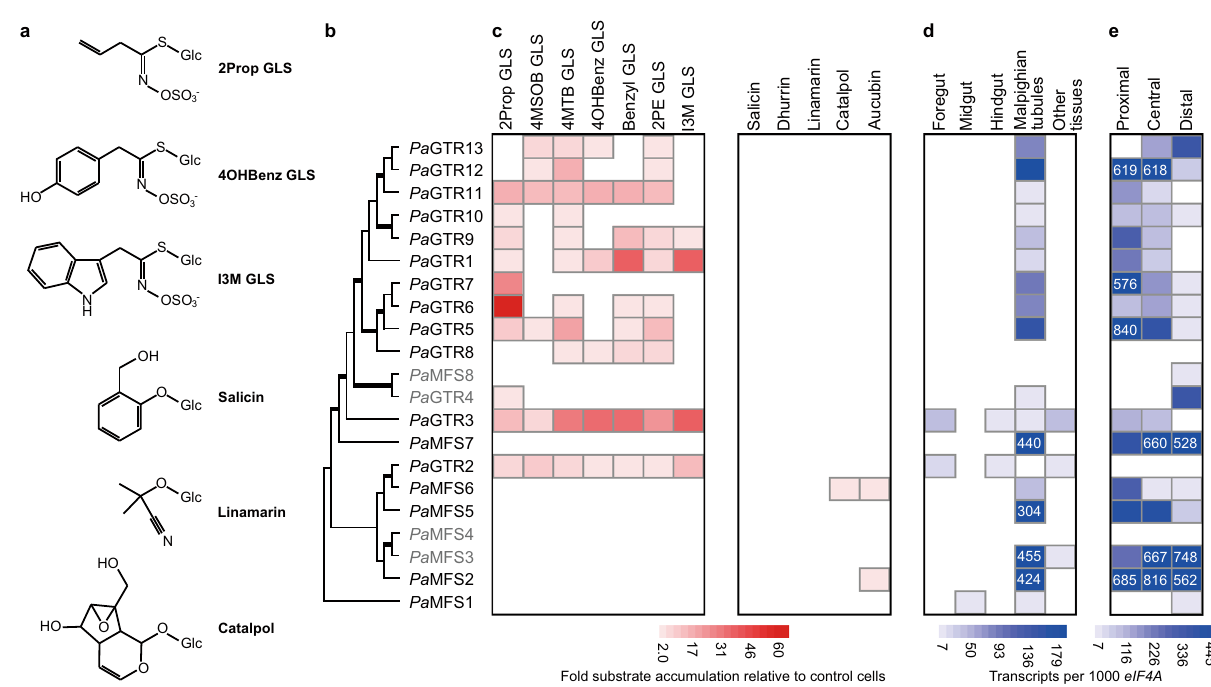
Fig. 1 Import activity and expression pattern of candidate MFS transporters. a Chemical structures of selected glucosinolates (GLS) and nonhost glucosides used in transport activity assays. b Phylogenetic relationships of candidate transporters selected based on the diversi fi cation pattern of coleopteran MFS transporters shown in Supplementary Data 3. Branches shown in bold have a bootstrap support >95%. Recombinant proteins expressed in High Five insect cells were detected by Western blotting. For four candidates, we did not detect recombinant protein (Supplementary Fig. 1); the names of these candidates are written in gray. c Recombinant transporters were screened for glucoside uptake activity in assays using equimolar mixtures of glucosinolates or nonhost glucosides. Glucoside accumulation in transfected insect cells is expressed relative to that in mock-transfected insect cells used as background control. Values represent the mean of three assays. d Expression pattern of candidate MFS transporter genes in different tissues of P. armoraciae . e Expression pattern of candidate MFS transporter genes in different regions of the Malpighian tubule. Copy number estimates are given per 1000 copies of mRNA of the reference gene eIF4A . Low gene expression levels are visualized by limiting the scale to a value of 200 and 500 in ( d ) and ( e ), respectively. The exact values are provided for genes with higher expression levels. Each value represents the mean of four and three biological replicates in ( d ) and ( e ), respectively. 2Prop 2-propenyl, 4MSOB 4-methylsul fi nylbutyl, 4MTB 4-methylthiobutyl, 4OHBenz 4-hydroxybenzyl, 2PE 2-phenylethyl, I3M because this transporter prefers indol-3-ylmethyl (I3M) glucosi-